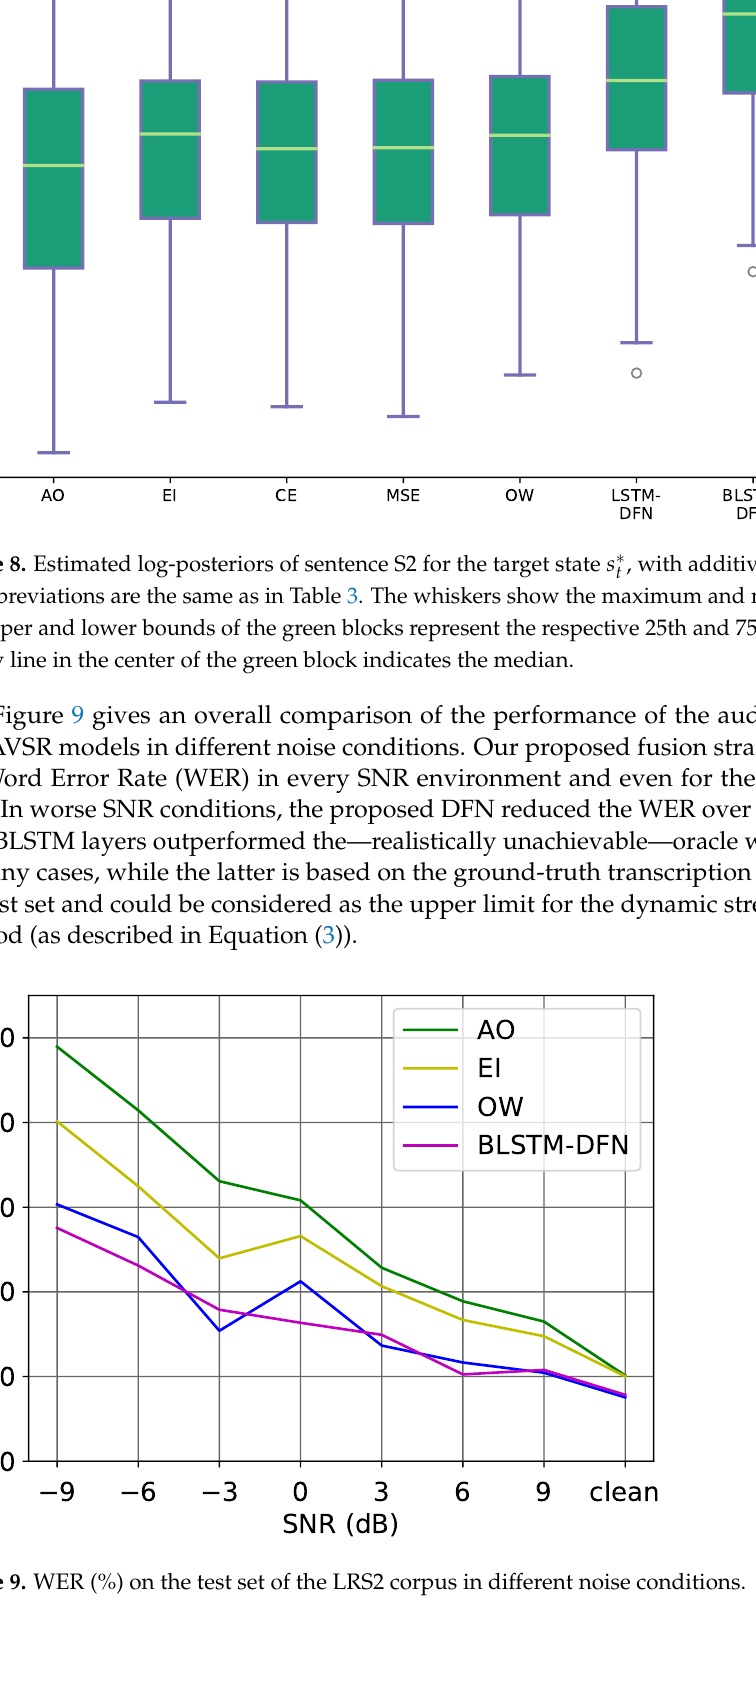
Figure 9. WER (%) on the test set of the LRS2 corpus in different noise